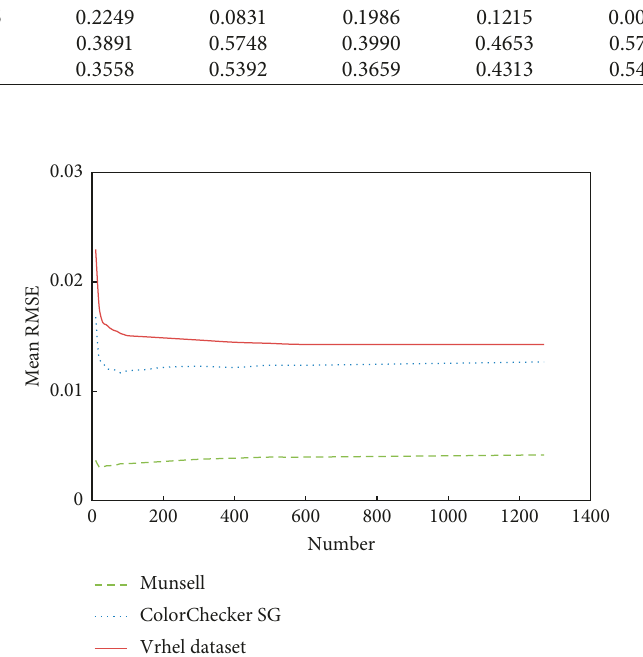
Figure 1: Relationship between the number of local training samples and mean RMSE of the Munsell chips, ColorChecker SG, and Vrhel